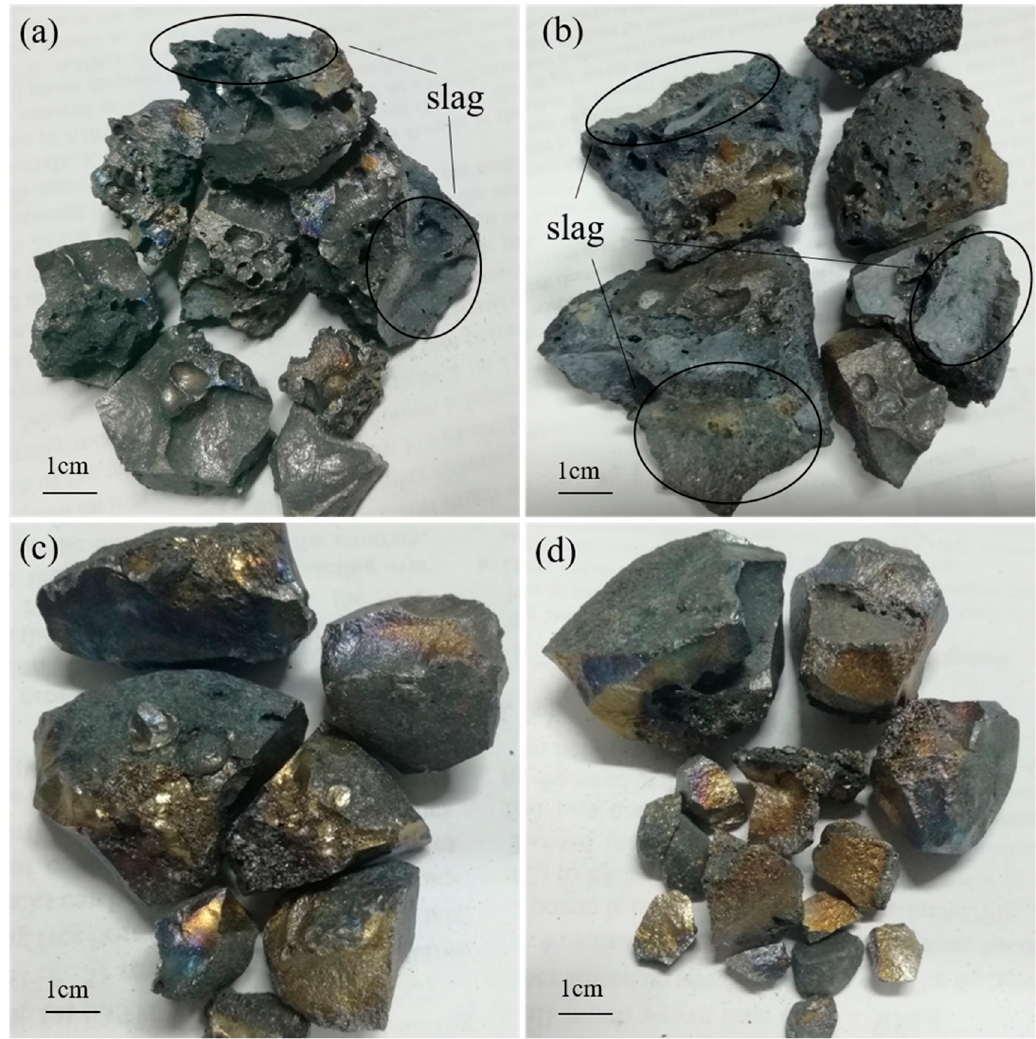
Figure 4. Macroscopic morphology of ferrotitanium produced from ilmenites with different reduction degrees. ( a ) 0%, ( b ) 11%, (c) 43%, and ( d ) 75%.